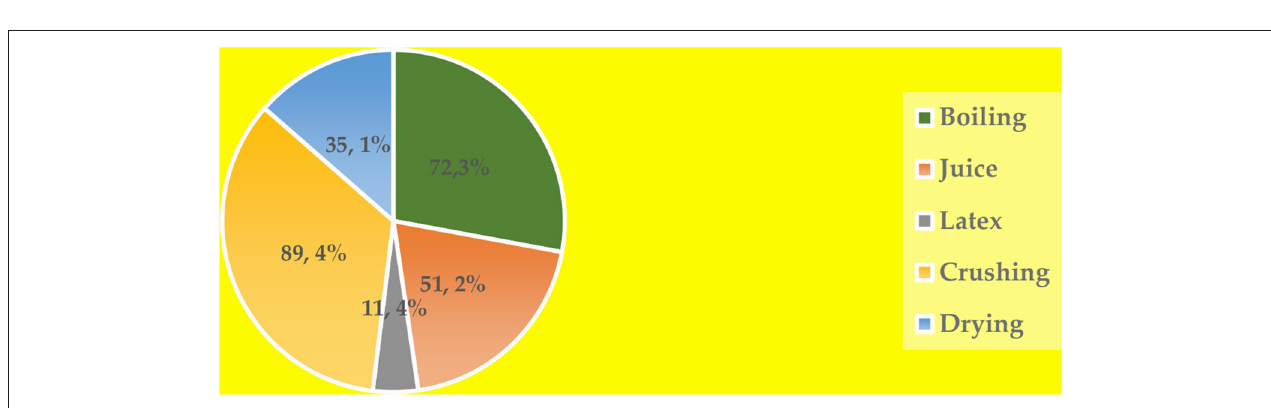
FIGURE 2 | Plant families and number of plant species used in EVM in Omusati and Kunene regions of Namibia.